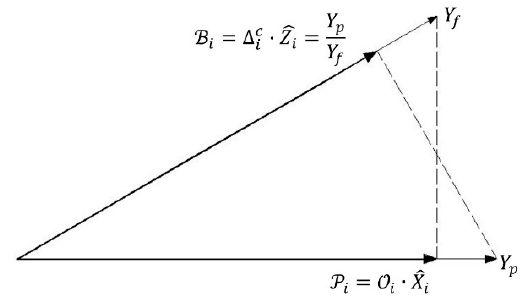
Figure 4. Orthogonal projection matrix.